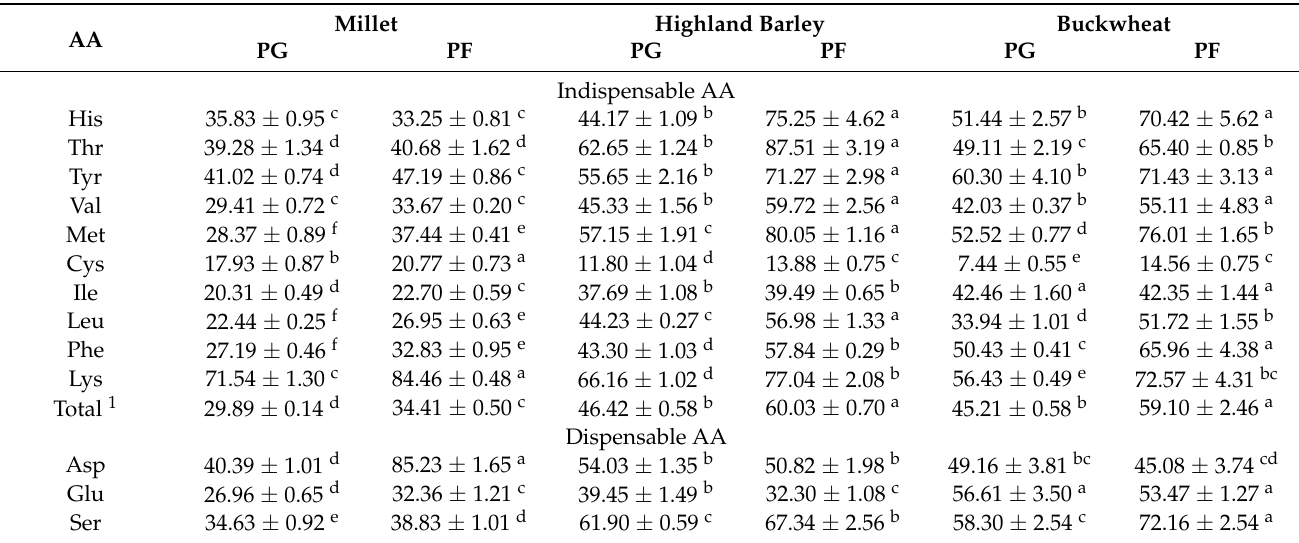
Table 3. Intestinal digestibility (%) of amino acid (AA) in cereal-based foods produced by grains (PG) or flour (PF) from millet, highland barley and